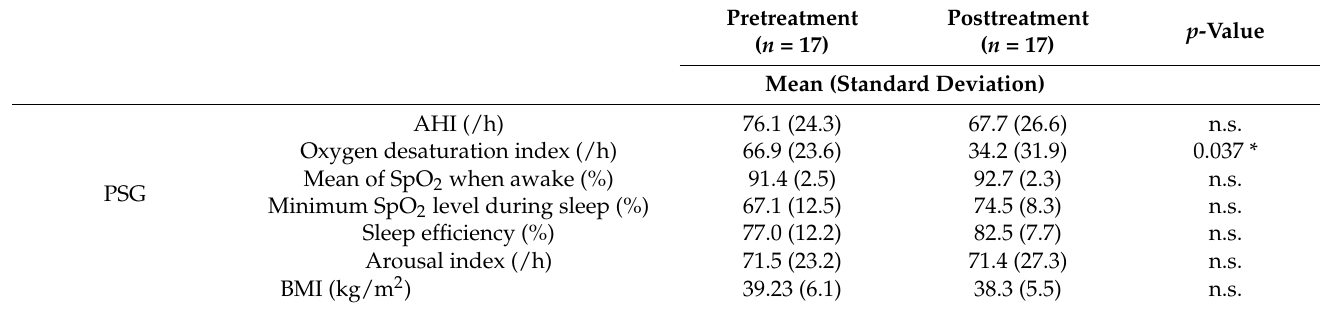
Table 2. Polysomnography data of subjects who continued